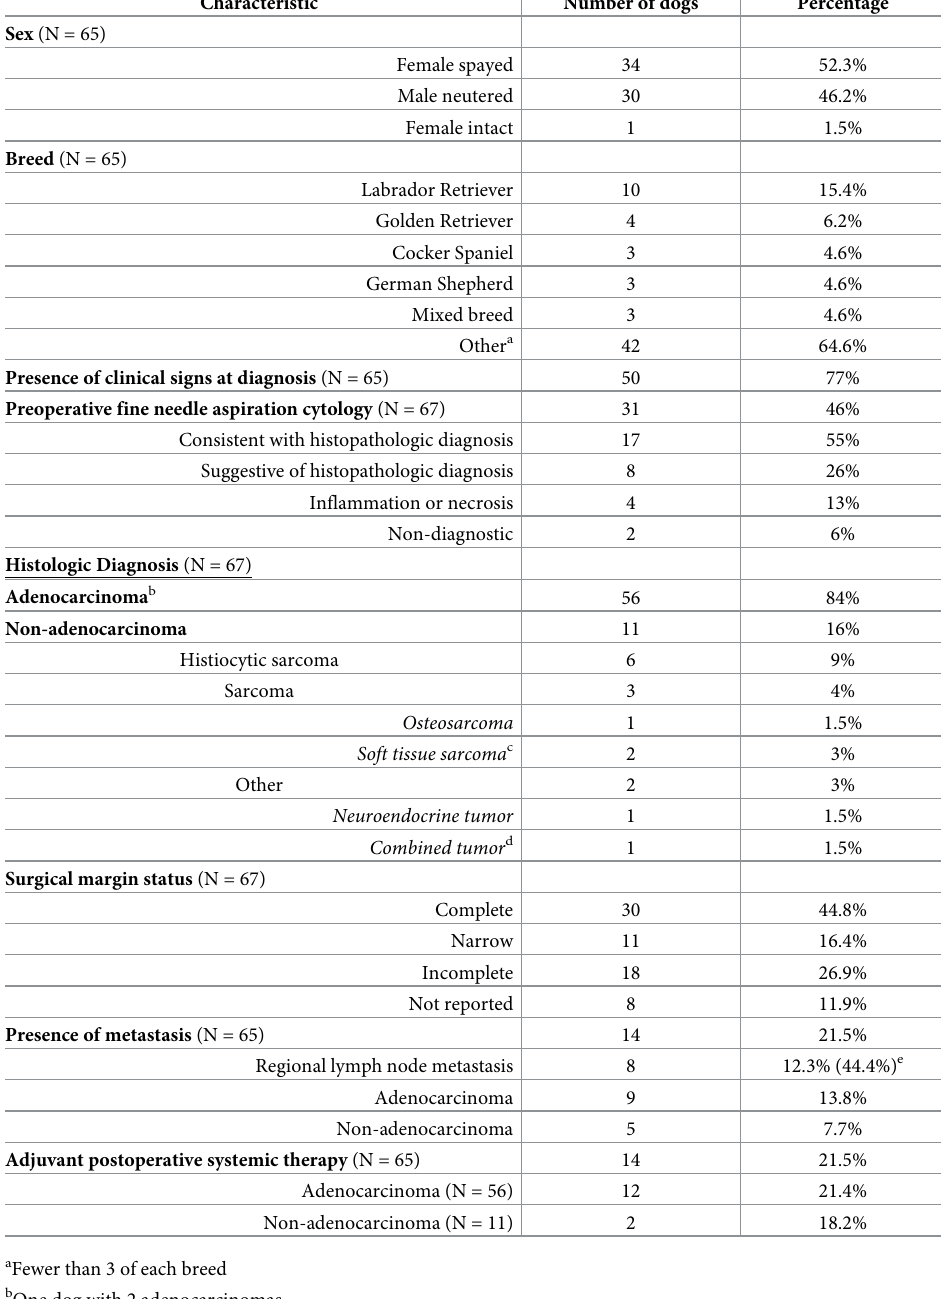
Table 1. Clinical characteristics of 65 dogs included for evaluation of 67 primary lung tumor radiomic and histo- logic